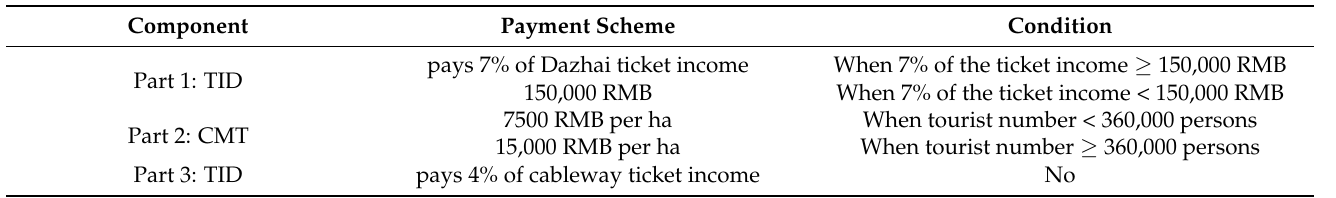
Table 4. The scheme that TID and CMT were paid by Longji Tourism Company and GJP Cableway Company to Dazhai from 2013 to now. Component Payment Scheme Condition